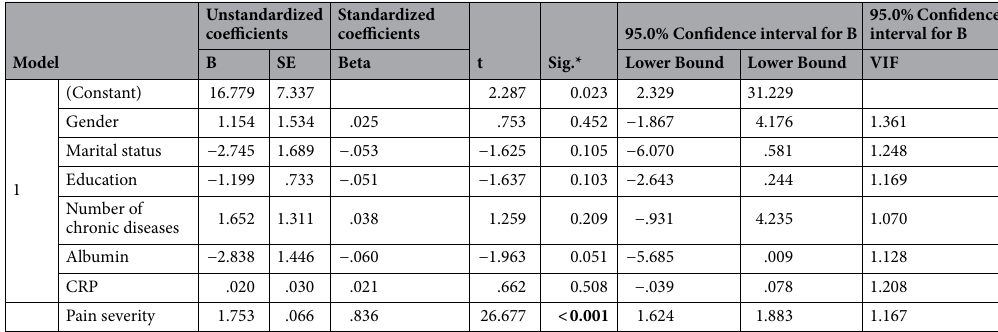
Table 6. Multivariate linear regression analysis of the pain interference score. a. Dependent Variable: pain interference. *The bold p value indicates that < 0.05, which considers significantly.